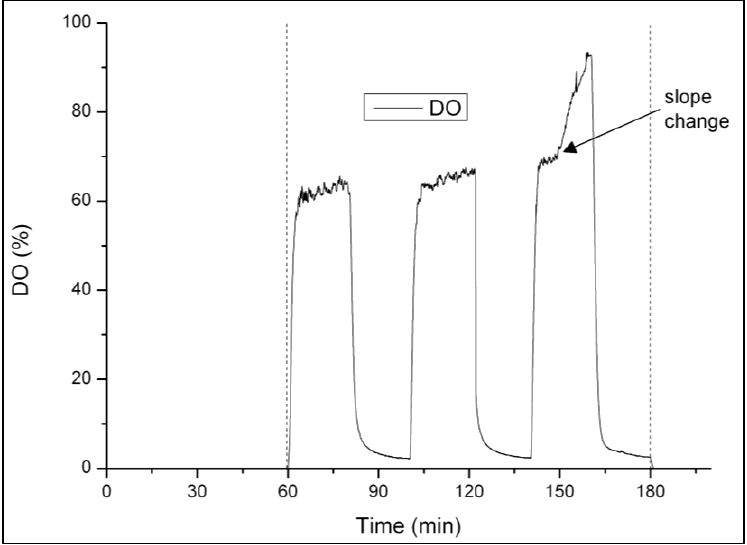
Figure 2. Illustration of a DO profile during a SBR cycle with alternate high-low DO periods with full aeration during the high DO periods. The slope change of DO towards the end of nitrification occurring during the third high DO period is